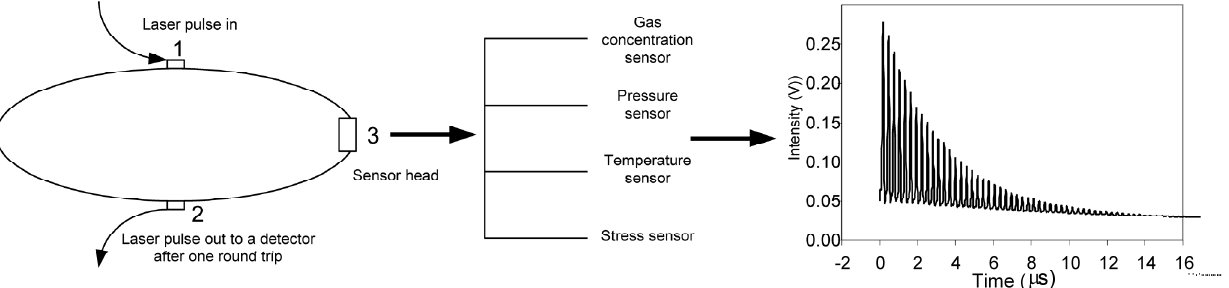
Figure 2. Fiber Loop Ringdown (FLRD) – a universal time-domain sensing